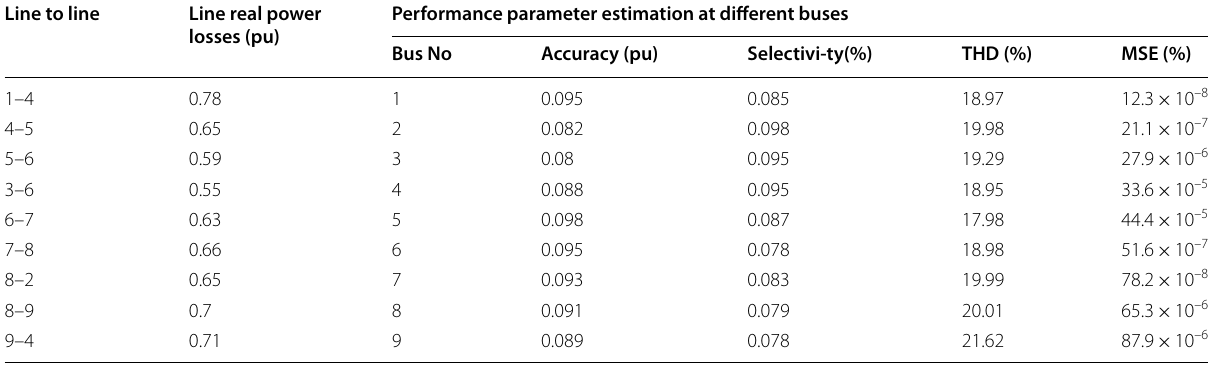
Table 2 Performance parameter analysis of standard IEEE-9 bus system without DG using NR method Line to line